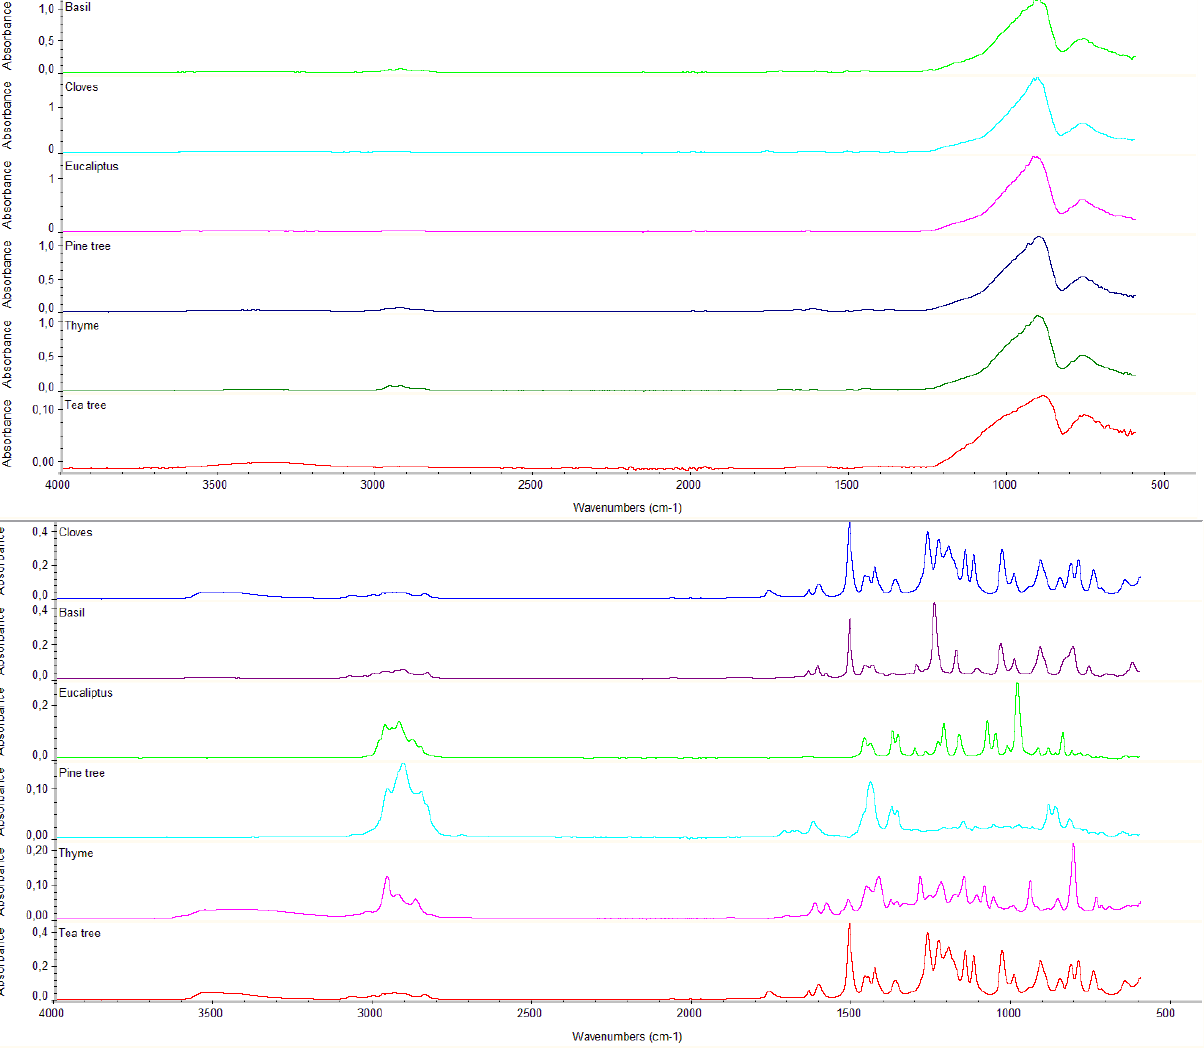
Figure 3. Overlaying of the FTIR spectra of the EOs tested without the presence of thickener and after drying ( top ) and with the presence of thickener before the drying process ( below ).